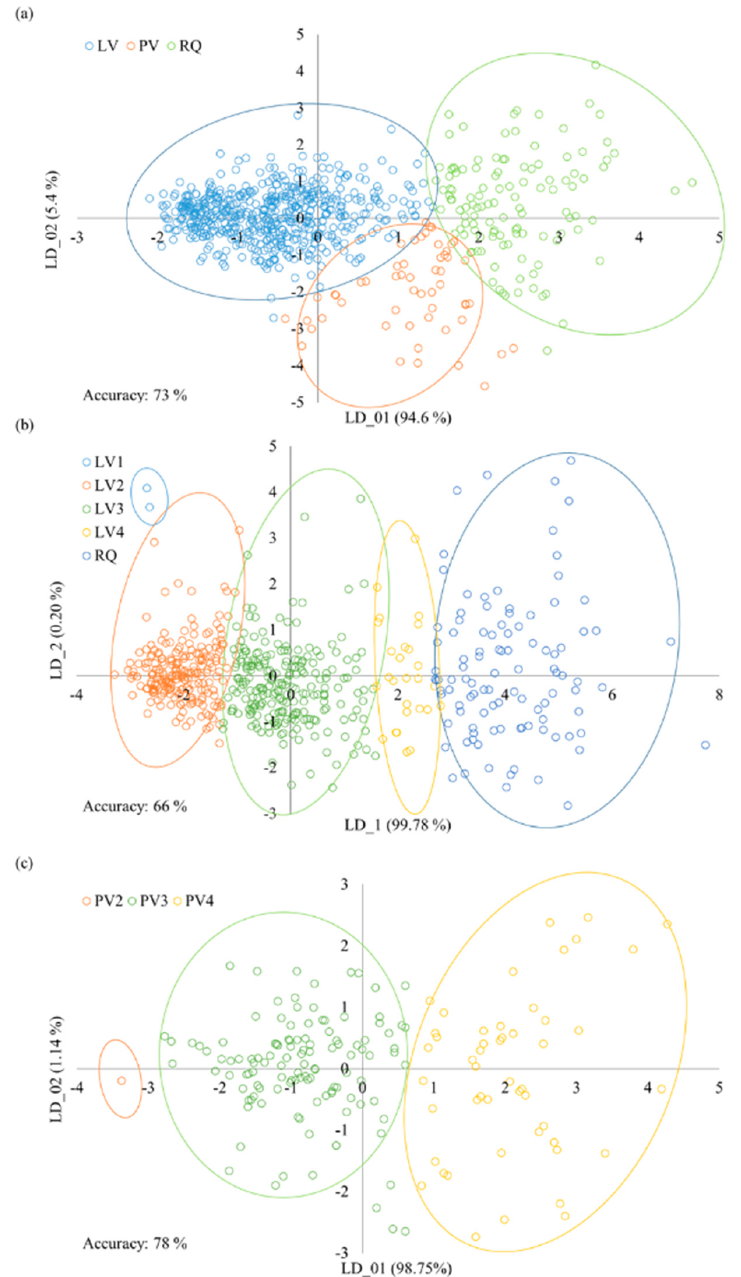
Figure 9. Predicted discrimination among: ( a ) Ferralsols (LV), Lixisols (PV) and Arenosols (RQ); ( b ) Ferralsols with different textures and Arenosols; and ( c ) Lixisols with diferrent textures.